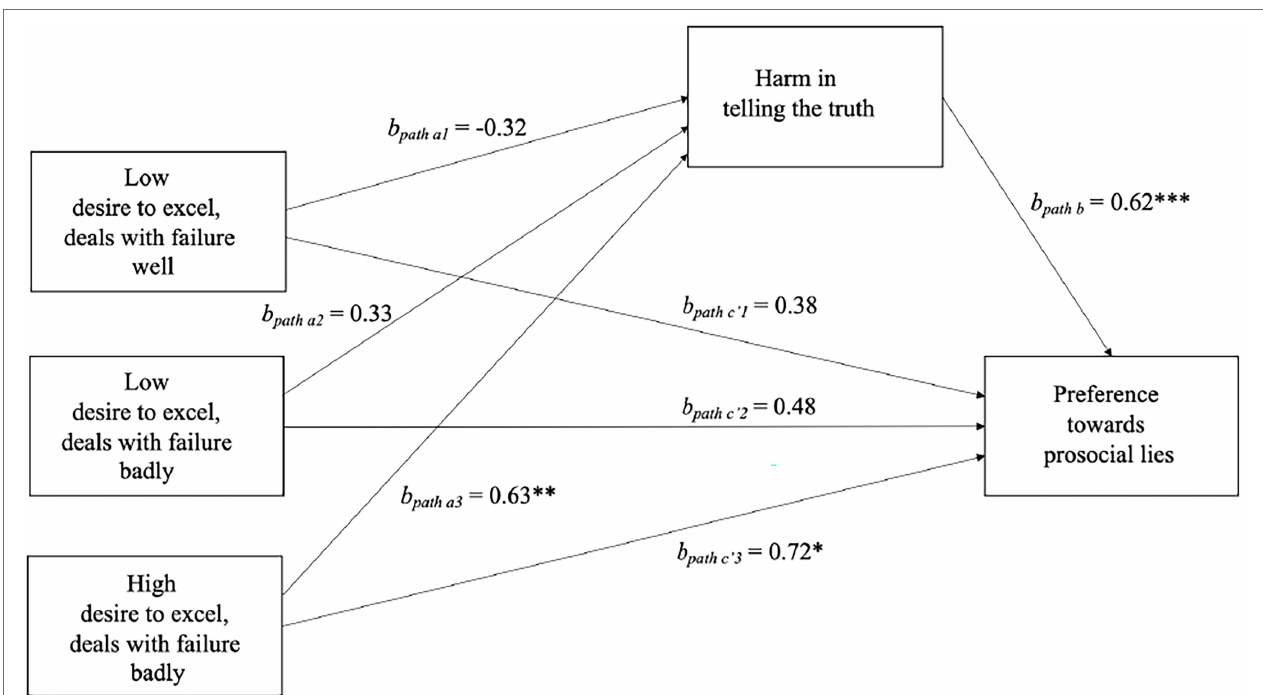
FIGURE 2 | Mediation model testing that harm in telling the truth mediates the effect of desire to excel and ability to deal with feedback on preference toward prosocial lies. In this model, high desire to excel in a task and dealing with feedback well is the reference group, * p < 0.05, ** p < 0.01, *** p <